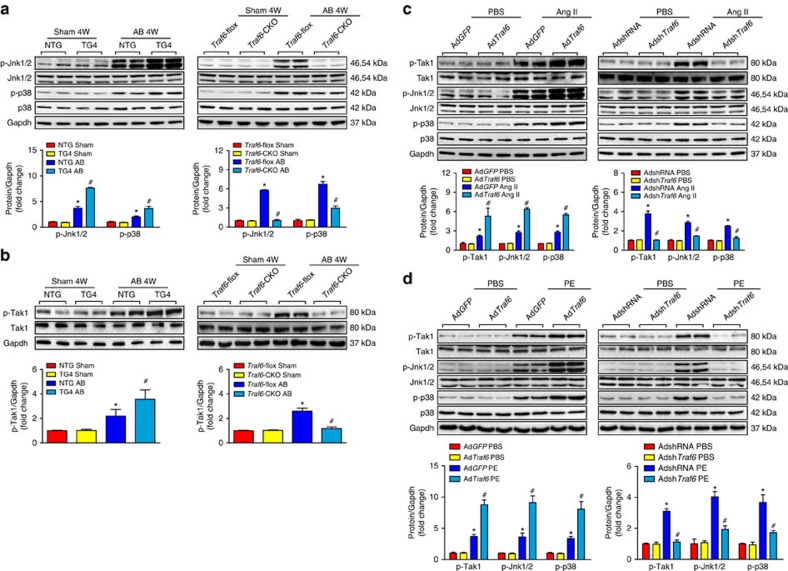
The TAK1-JNK1/2/p38 axis is involved in TRAF6-regulated cardiac hypertrophy.(a) Western blots showing the phosphorylation and total protein levels of Jnk1/2 and p38 in heart tissues from NTG and TG4 mice (left) or WT and Traf6-CKO mice (right) 4 weeks after AB surgery. (b) The phosphorylation and total protein levels of Tak1 in heart tissues in the indicated groups. For (a,b) n=4 mice per group, *P<0.05 versus Traf6-flox sham or NTG sham; #P<0.05 versus Traf6-flox AB or NTG AB. (c,d) The protein levels of phosphorylated and total Tak1, Jnk1/2 and p38 in NRCMs infected with AdGFP and AdTraf6 (left) or AdshRNA and AdshTraf6 (right) treated with Ang II (c) or PE (d) (*P<0.05 versus AdGFP PBS or AdshRNA PBS, #P<0.05 versus AdGFP Ang II/PE or AdshRNA Ang II/PE). Data are presented as the mean±s.d. from at least three independent experiments. Statistical analysis was carried out by one-way ANOVA.